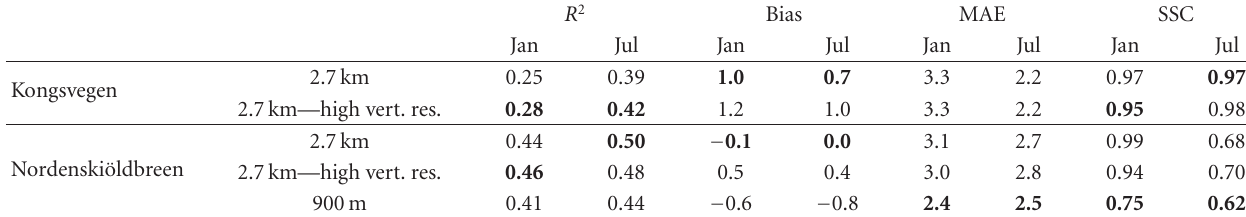
Table 14: Wind speed statistics in summer and winter 2009-2010 in 2.7km resolution, with and without increased vertical resolution in the boundary layer (high vert. res.) and in 900m resolution. Bold numbers indicate the best result for each AWS. Vestfonna data are not used here because of the lack of data during the chosen